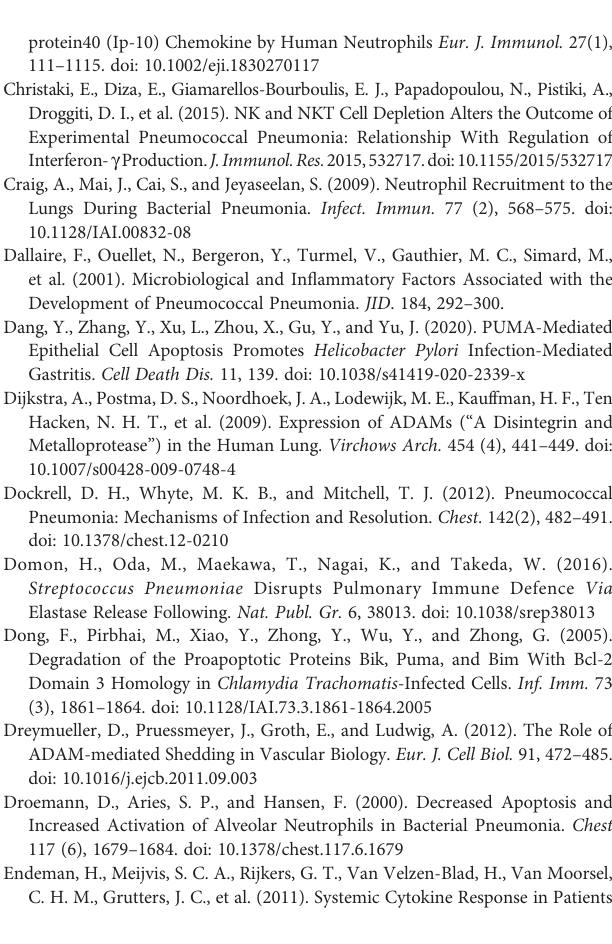
expressed genes are listed. Adjusted p-values and fold-enrichment scores are